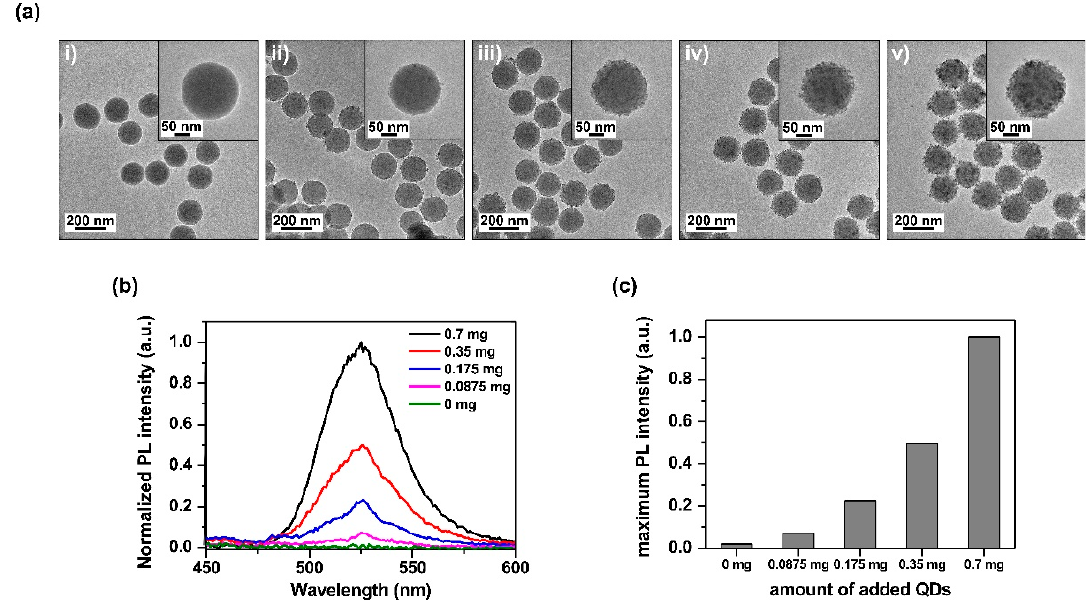
Figure 3. Brightness control of SiO 2 @InP QDs@SiO 2 NPs. ( a ) TEM image of SiO 2 @InP QDs@SiO 2 NPs via the amount of added QDs. The amount of added QDs were ( i ) 0 mg, ( ii ) 0.0875 mg, ( iii ) 0.175 mg, ( iv ) 0.35 mg, and ( v ) 0.7 mg per 1 mg of SiO 2 NPs. ( b ) Normalized PL intensity spectra of SiO 2 @InP QDs@SiO 2 NPs via amount of added QDs. ( c ) Maximum PL intensity of SiO 2 @InP QDs@SiO 2 NPs via amount of added QDs at 527 nm emission wavelength.